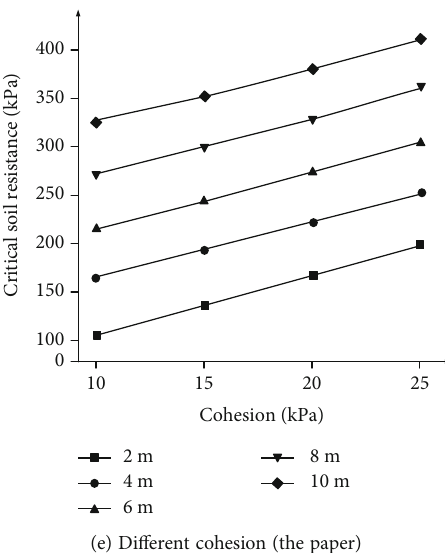
Figure 5: Comparison diagram of critical soil resistance.